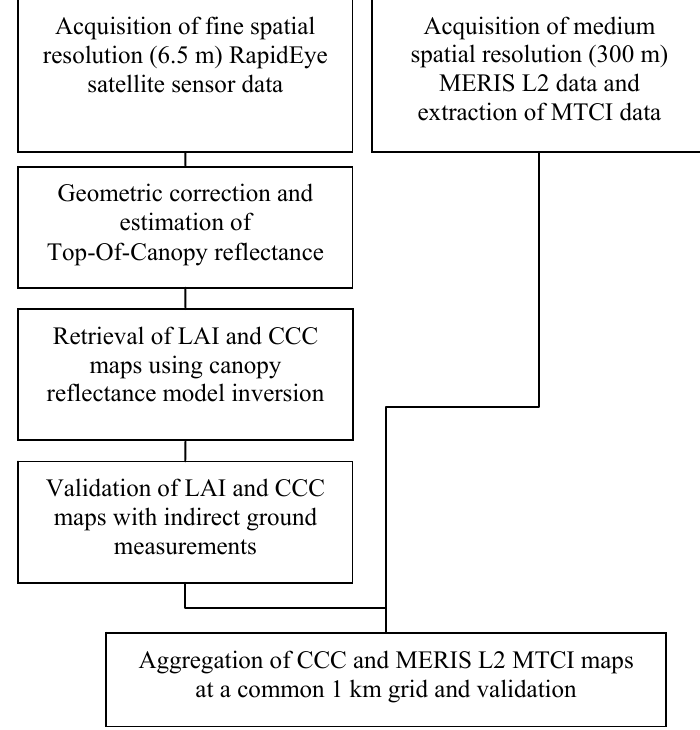
Figure 2. Schematization of the validation process for the Medium Resolution Imaging Spectrometer (MERIS) L2 Terrestrial Chlorophyll Index (MTCI) data. Similarly, this validation scheme was used for MERIS and Moderate Resolution Imaging Spectrometer (MODIS) leaf area index (LAI)